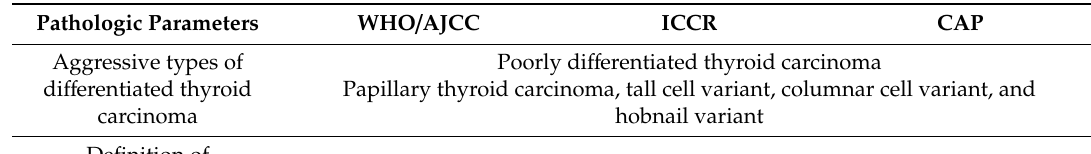
Table 1. Comparison of the key pathologic prognostic factors among di ff erent